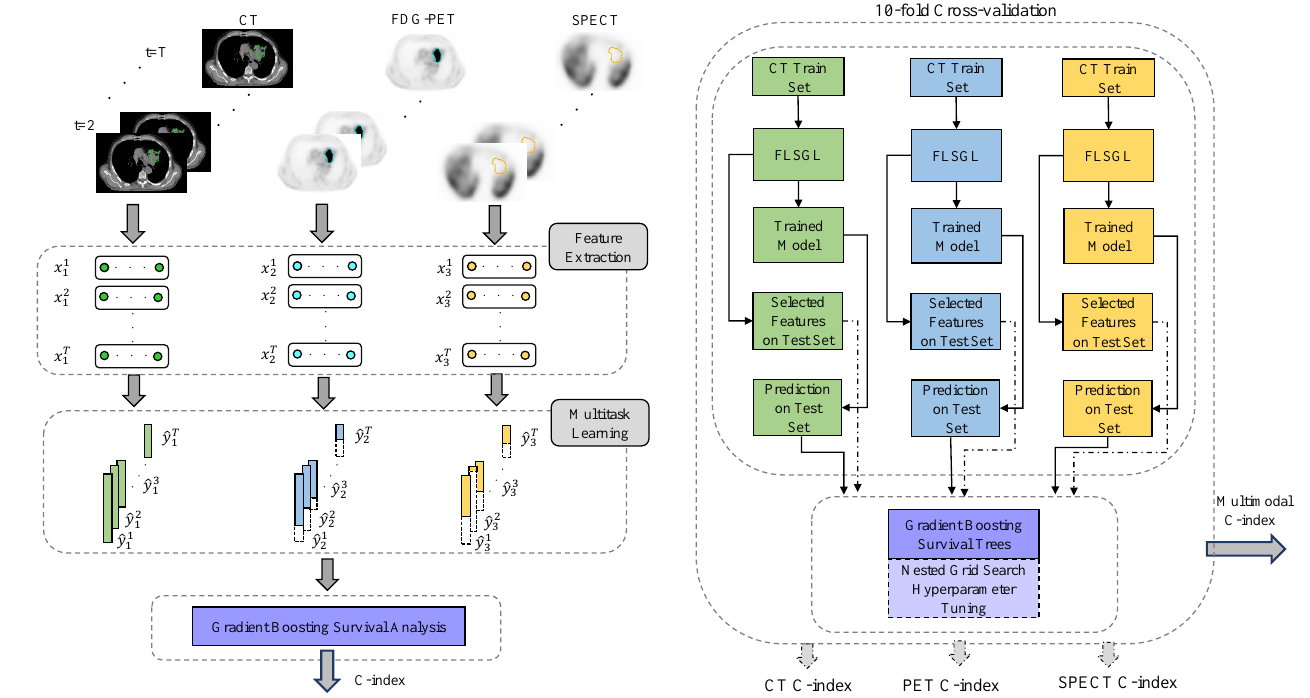
Figure 2. Overall schematic of survival outcome prediction pipeline using multitask feature selection across time points from single/multimodality radiomics ( left ) and steps inside the stratified cross- validation folds for multitask and gradient boosting survival ( right ). Note that feature selection and nested grid search for hyperparameter tuning were constrained to training folds and blinded to test folds, in order to prevent data leakage for unbiased performance